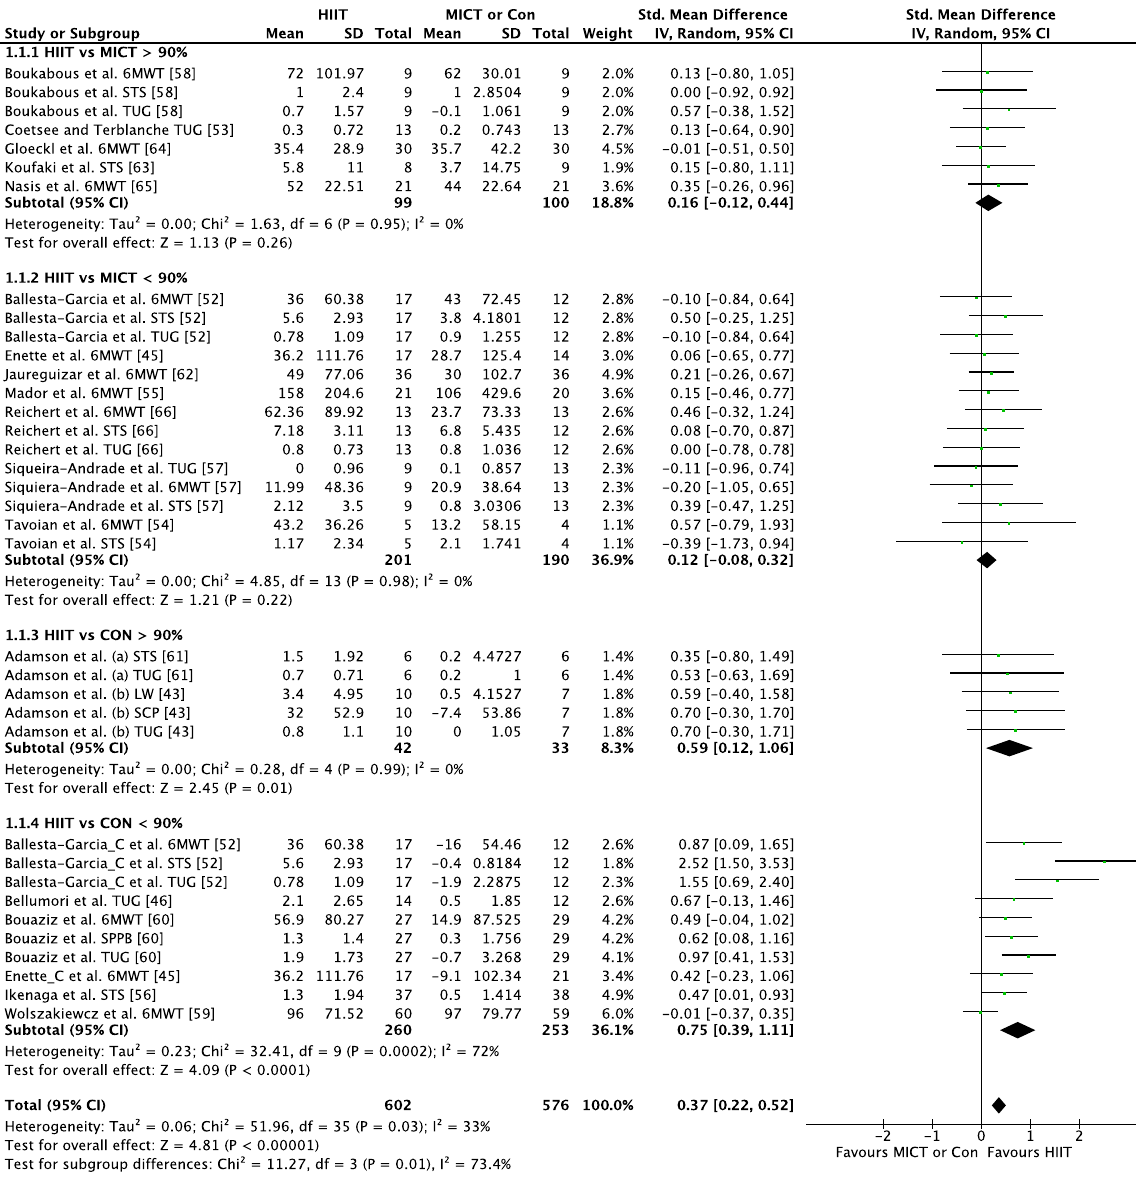
Fig. 7 Meta-analysis subgroups HIIT versus MICT, HIIT versus Control with subgroups > 90% HIIT interval intensity and < 90% HIIT interval intensity with all functional movement outcome measures for each